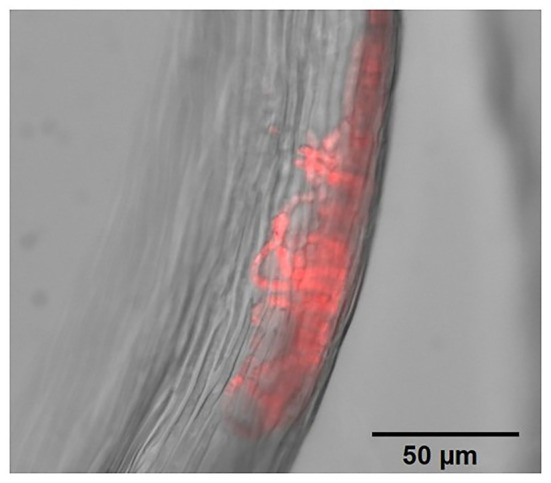
Filamentous cyanobacteria colonies (phycocyanin fluorescence in red) within Ptilium crista-castrensis leaves, observed under an epifluorescence microscope (Zeiss Axio Observer Z1 equipped with a Zeiss Axiocam 506 mono, objective 40X/0.95NA). For widefield fluorescence, an excitation filter of 533–558 nm and an emission filter of 570–640 nm were used.